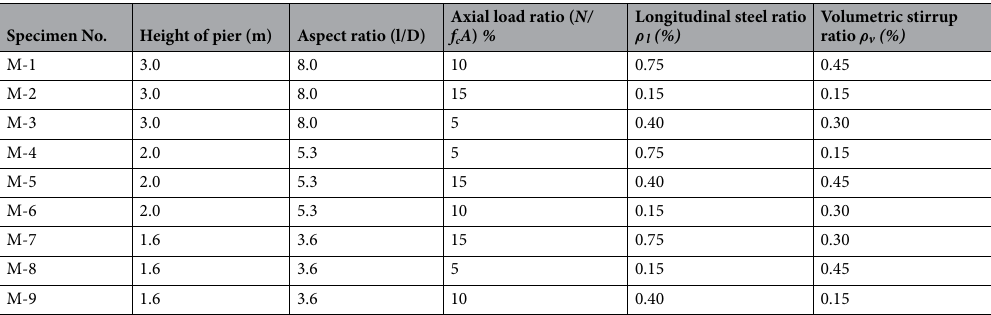
Table 1. Combination of variables of RERSCSS concrete piers used in the HSRB model. Note: fc denotes the axial compressive strength of concrete; A denotes the compressive area of concrete; N denotes the axial load of the model. L is the pier height; D is the outer diameter of the round end for the M-7–M-9 model, D = 0.375 m; for the M-1–M-6 model, D = 0.44 m (Fig. 3).